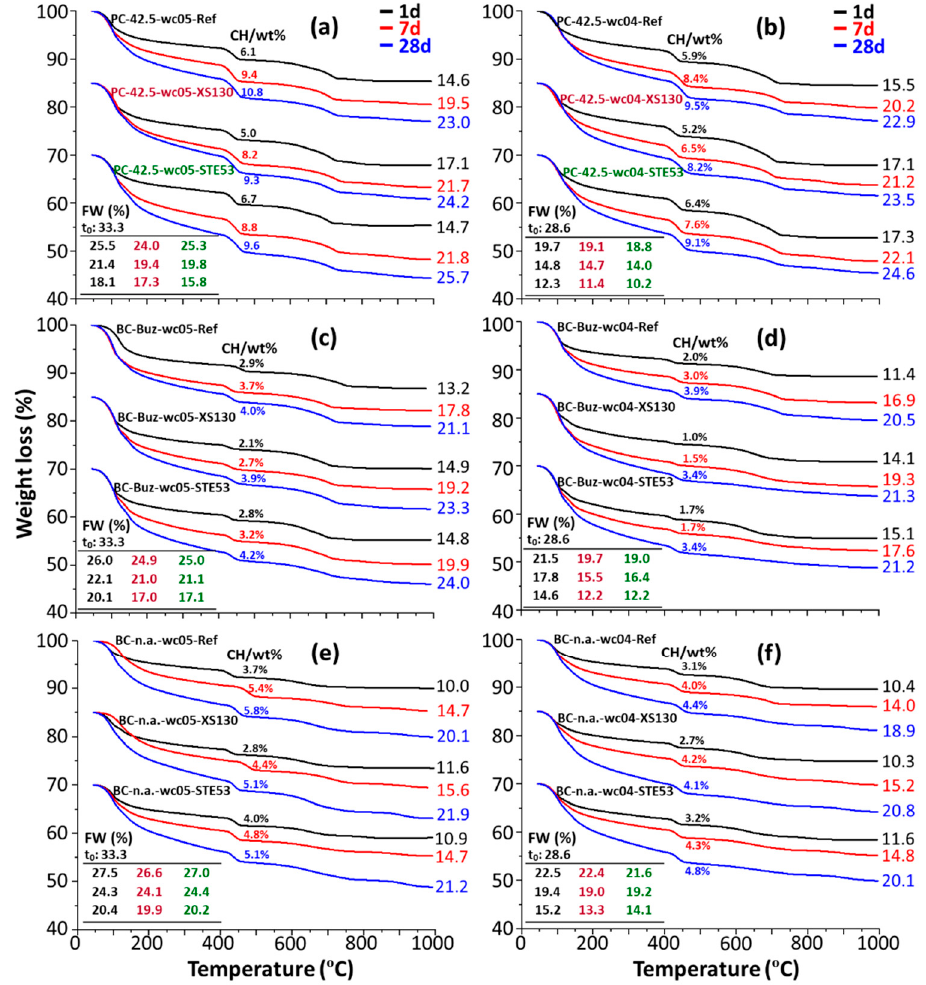
Figure 3. The fifty-four thermal analysis traces for the pastes after arresting the hydration and holding 30 min at 40 °C. The curves for the series have been vertically displaced for clarity. ( a ) PC-42.5 w / c = 0.50; ( b ) PC-42.5 w / c = 0.40; ( c ) BC-Buz w / c = 0.50; ( d ) BC-Buz w / c = 0.40; ( e ) BC-n.a. w / c = 0.50; ( f ) BC-n.a. w / c = 0.40. The Portlandite contents (wt%) given refer to the neat pastes, i.e., containing the free water, for direct comparison with the RQPA results. The total weight losses (wt%) are also displayed to the right of the traces. The insets give the free water contents, determined as described in the experimental section.